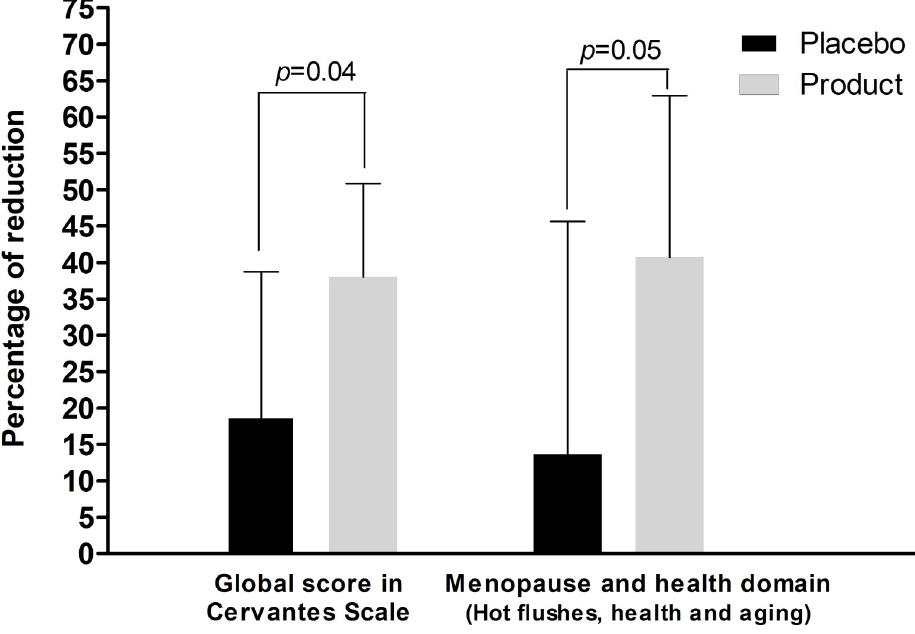
Fig 4. Self-reported Cervantes Scale. Percentage (%) of change in the overall Quality of Life score (global) and in the menopause and health domain (hot flashes, health, and aging) after treatment with the botanical extract combination ( Glycine max seed isoflavones + Aframomum melegueta seed extract + Punica granatum skin extract) or placebo. Data are expressed as median ±